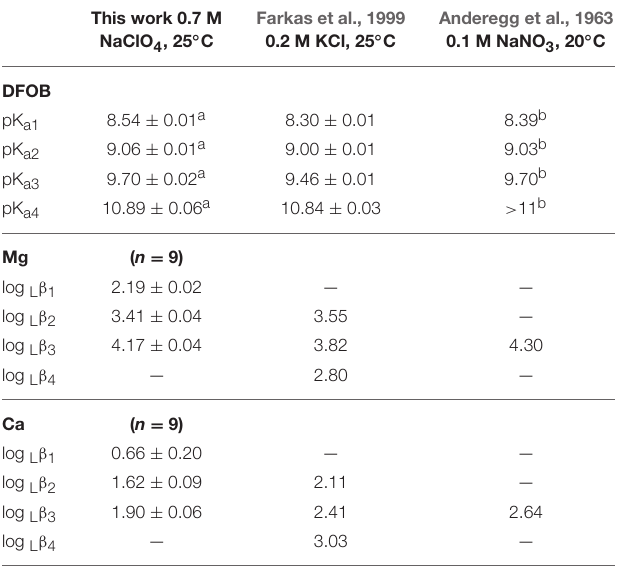
TABLE 8 | Stability constants for DFOB complexes of Mg and Ca, derived from potentiometric titrations. This work 0.7 M NaClO 4 , 25 ◦ C